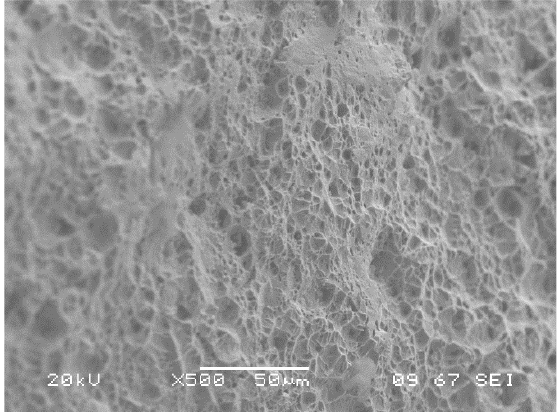
Figure 17. SEM pictures for “PE” under ELCF, show rough dimpled surfaces created by microvoids growth and coalescence with no signs of striations due to ELCF. The upper and lower images show a magnification of X1500 and X500, respectively.